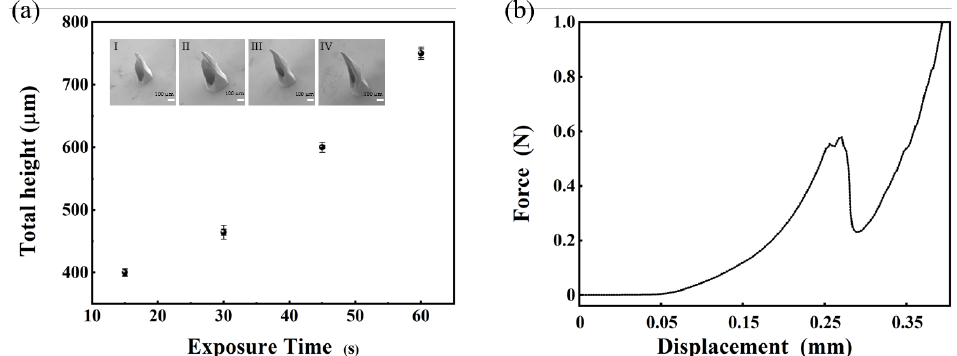
Figure 5. ( a ) Microneedle length and SEMs image at different exposure times. ( b ) The fracture force per needle of the exposure duration of 45 s.